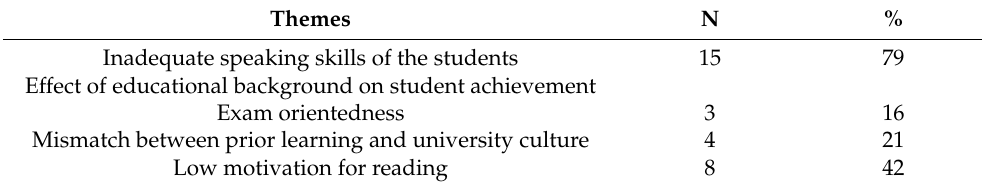
Table 5. Emerging themes of the interviews with department teachers.